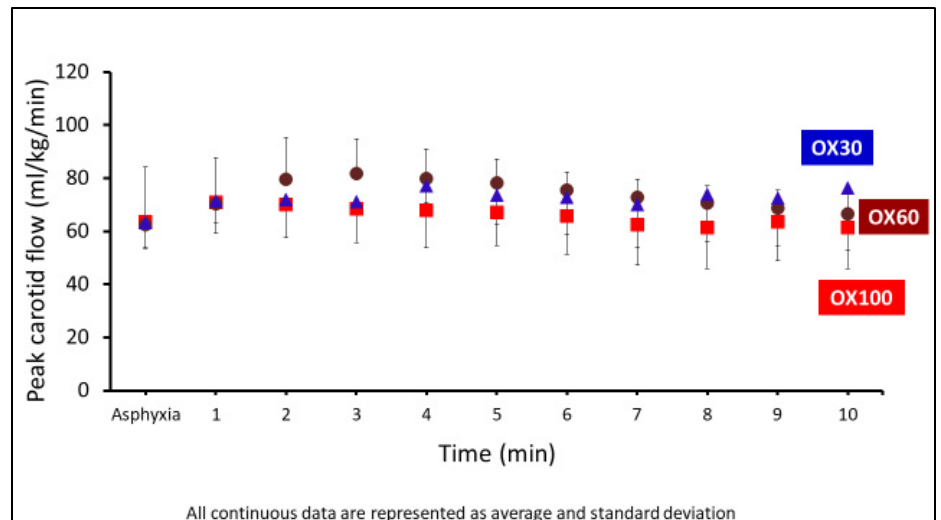
Figure 5. The graph shows the peak carotid blood low (CBF) (obtained from the left carotid artery) in mL/kg/min on the y -axis and the events in min on the x -axis. The CBF was not different between the groups. Data are represented as average and standard